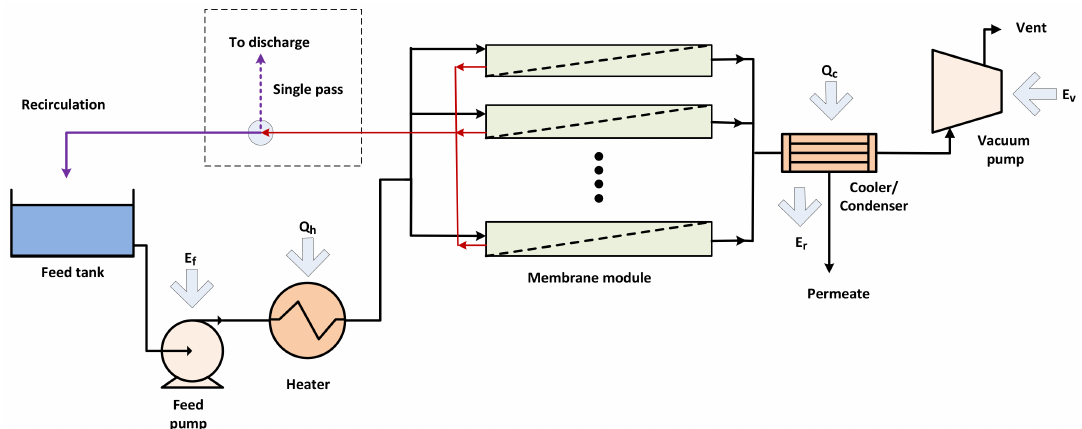
Figure 1. Schematic flow chart of pervaporation (PV) process in recirculation/single pass mode.